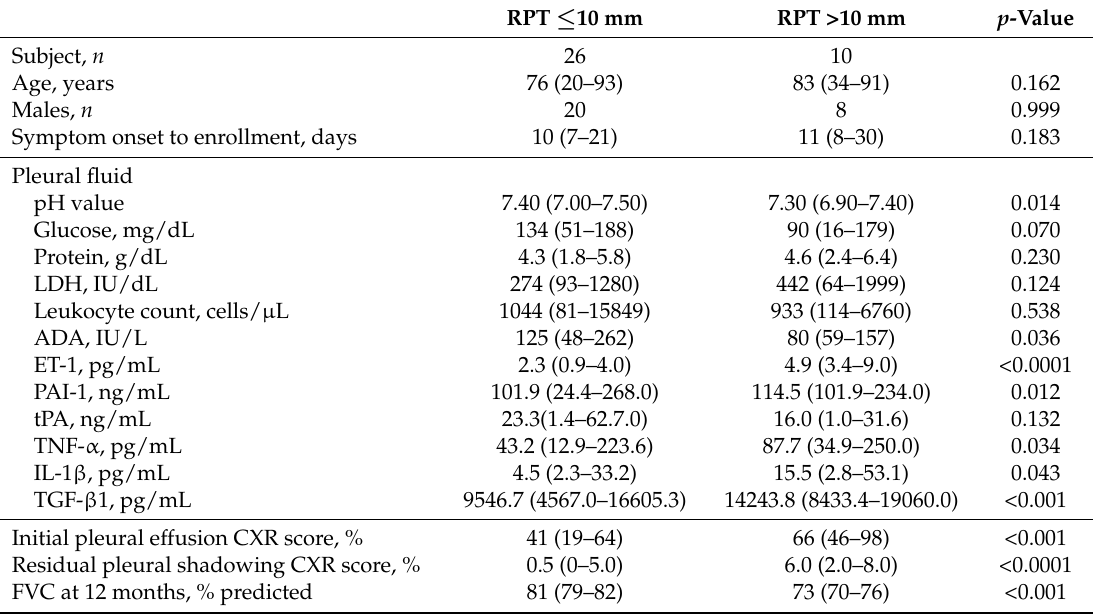
Table 2. Demographics, pleural fluid characteristics, and effusion levels of fibrinolytic factors and cytokines between TBPE patients with RPT ≤ 10 mm and RPT >10 mm †